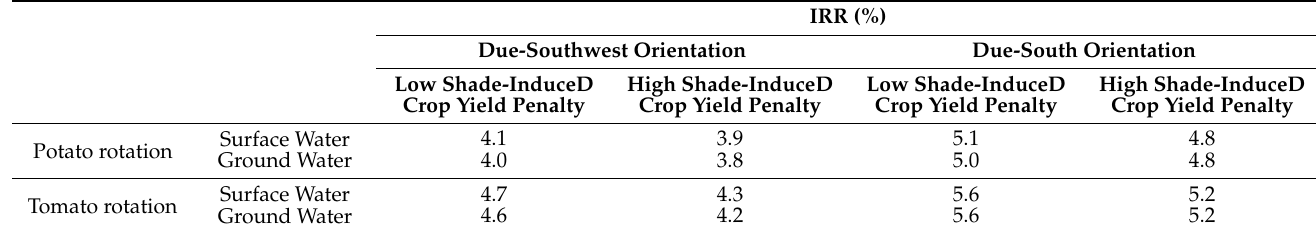
Table 9. Internal rate of return for the 16 combinations